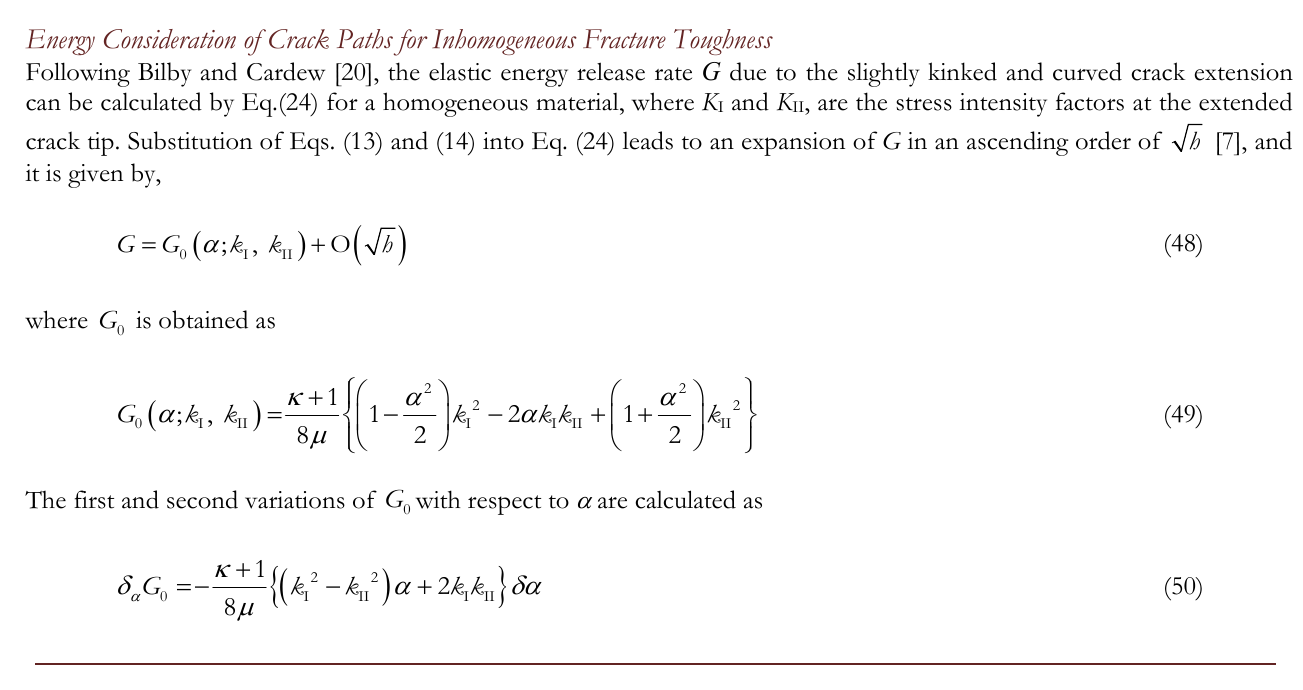
Figure 7: Crack paths observed in double-cantilever beam specimens [12,